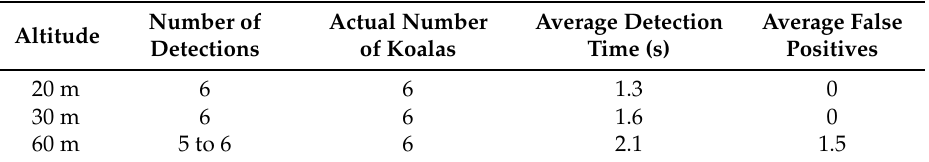
Figure 20. Orthomosaic thermal image with GPS location of detected koalas. Table 2. Comparison of number of detections, actual number of koalas, average detection time and average false positives.